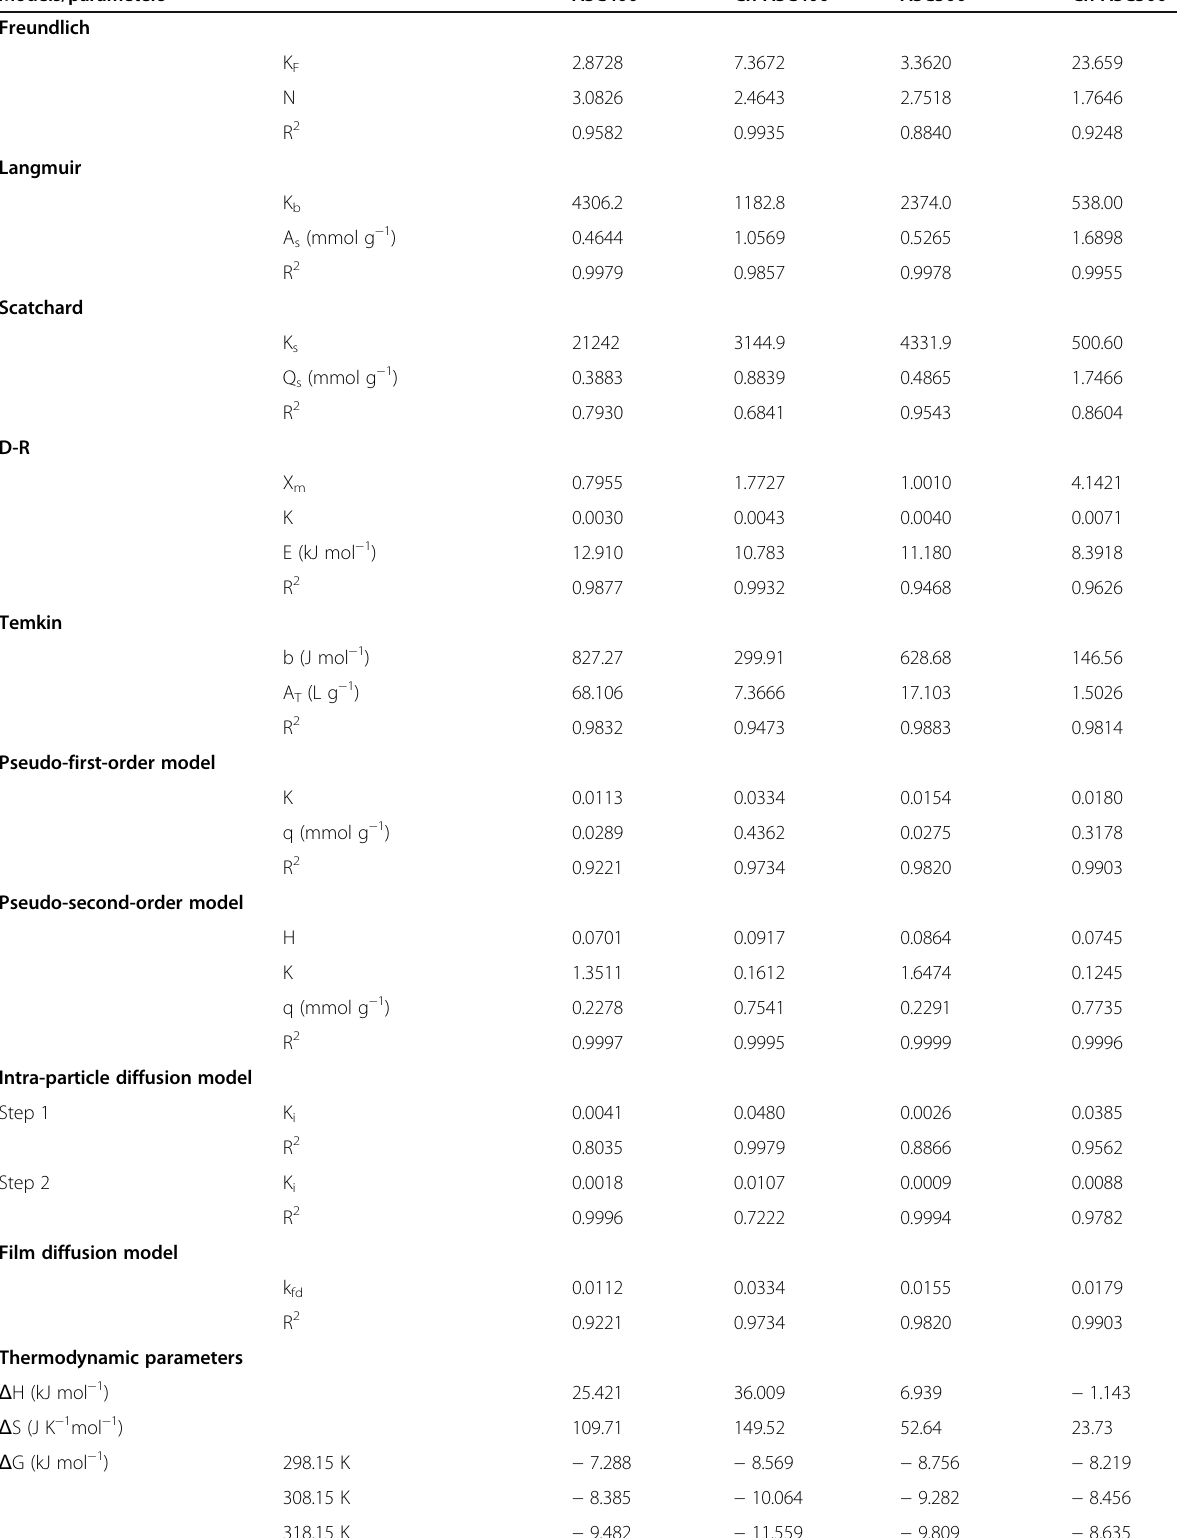
Table 1 Isotherm, kinetic, diffusion, and thermodynamic parameters and determination